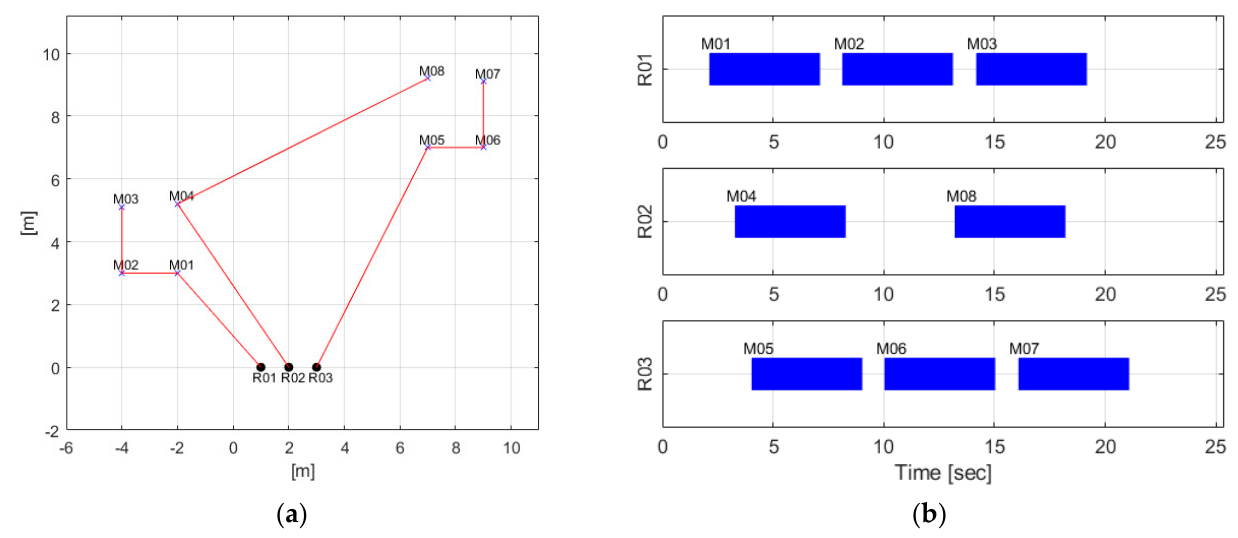
Figure 3. The results for simple case using proposed algorithm: ( a ) 2D situation map; ( b ) timetable.